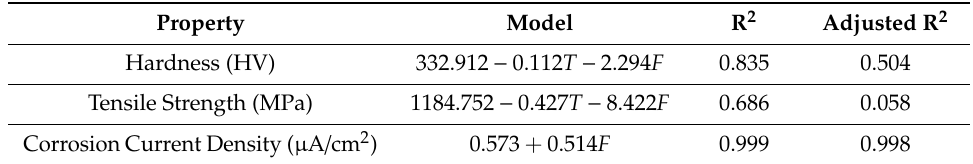
Table 11. Model summary of the properties of austenitic stainless steel in terms of delta ferrite composition.